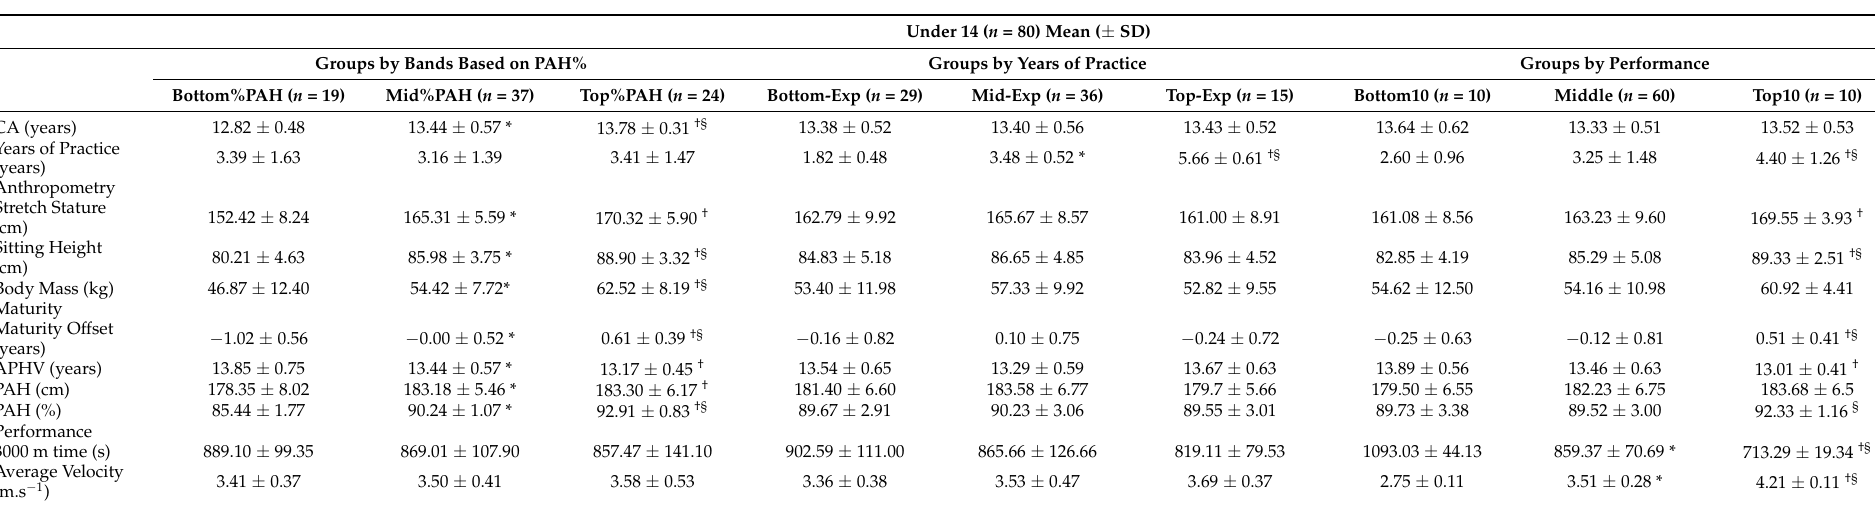
Table 2. Mean ( ± SD) for chronological age (CA), years of practice, anthropometry, maturity, and performance parameters for bands based on the percentage of predicted adult height (Bottom%PAH, Mid%PAH, and Top%PAH), grouped by years of practice (Bottom-Exp, Mid-Exp, and Top-Exp), and grouped considering performance (Top10, Middle, and Bottom10) for under 14